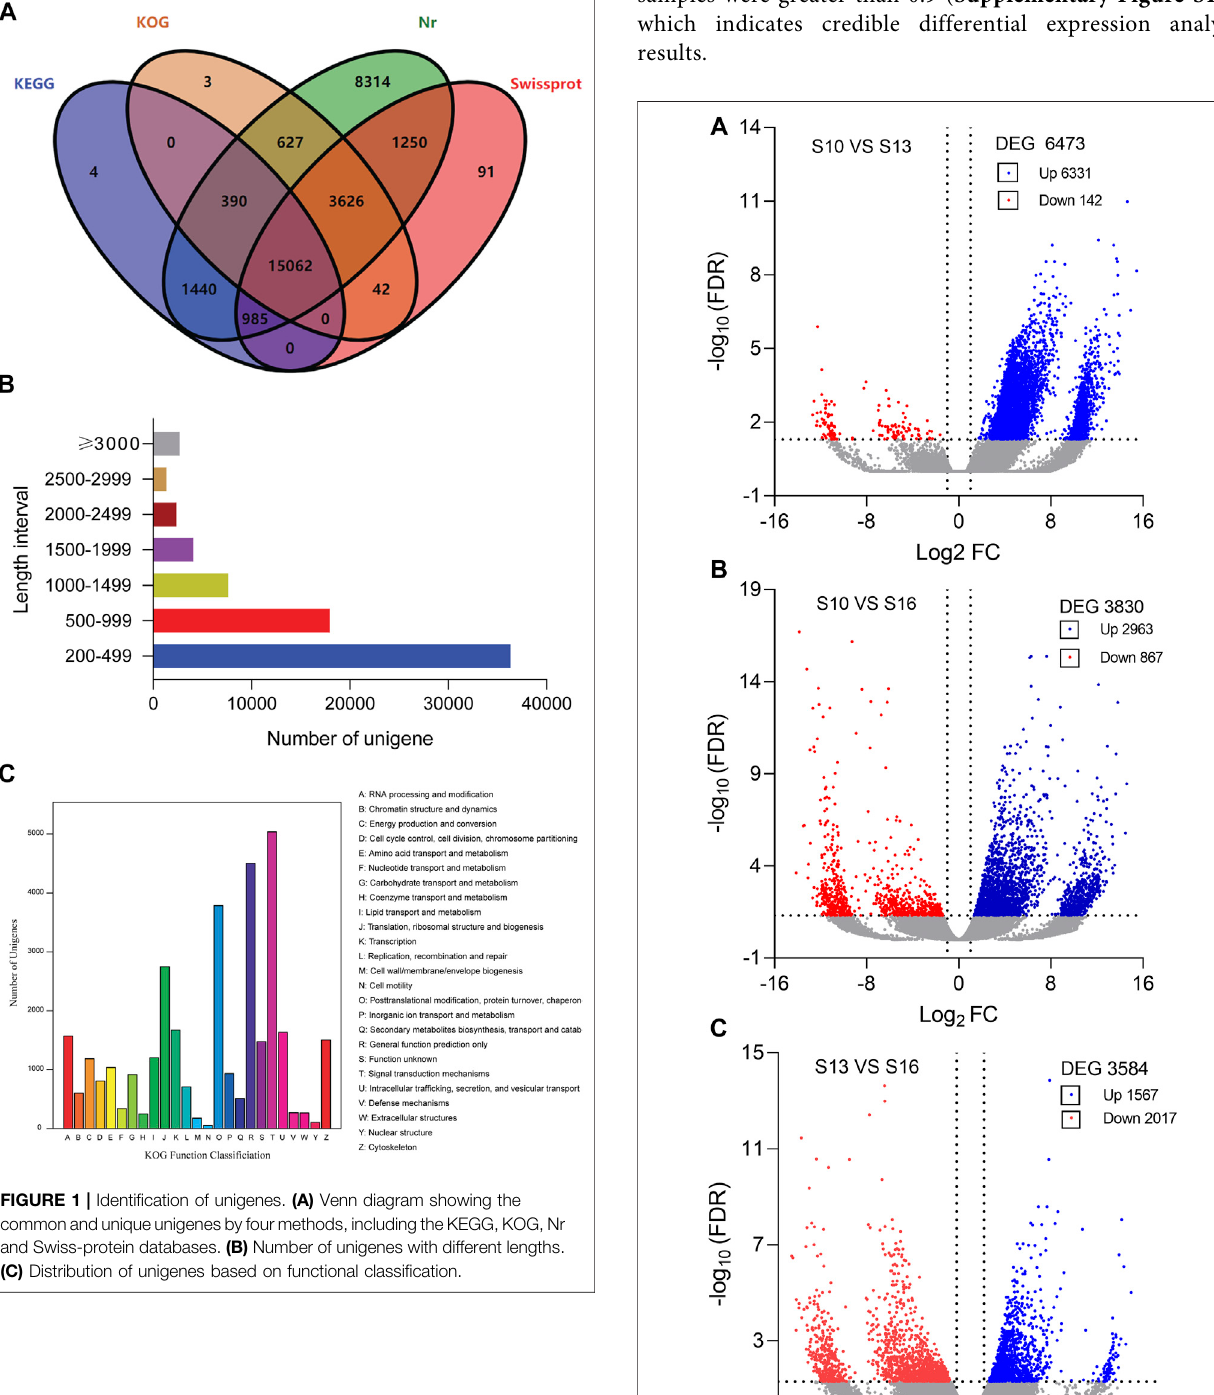
The gene expression levels for all the samples were evaluated by FPKM values ( Supplementary Figure S1A ). The correlation of gene expression levels between samples provides an important index for differential expression analysis, and most of the squared Pearson correlation coef fi cients ( R 2 ) between the